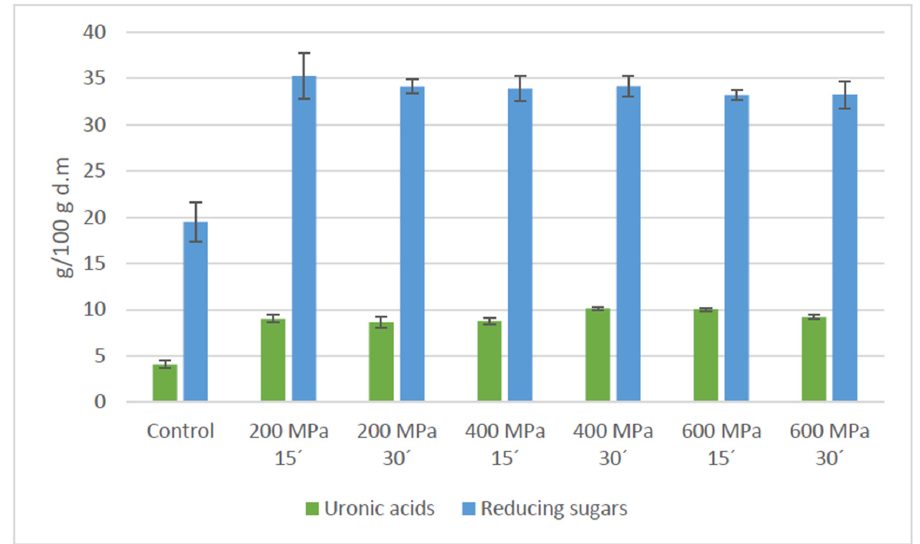
Figure 4. Determination of uronic acids and reducing sugars released from apple by-product by Celluclast ® (92 EGU) under high hydrostatic pressure at 200, 400 and 600 MPa for 15 and 30 min, respectively. Data are expressed as g/100 g dry